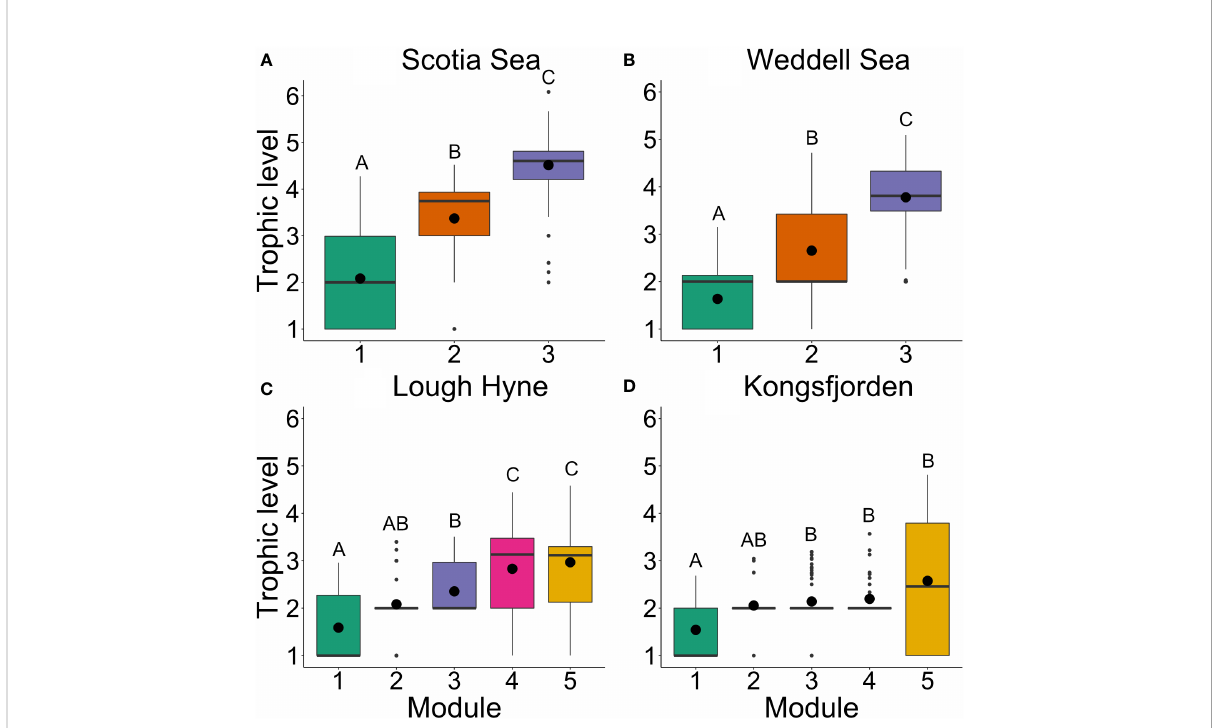
FIGURE 4 Boxplots of prey-averaged trophic level across modules within each network: (A) Scotia Sea; (B) Weddell Sea; (C) Lough Hyne; (D) Kongsfjorden. Large black points indicate the mean, thick horizontal lines represent the median, boxes indicate the interquartile range, whiskers are 1.5 × the interquartile range, and outliers beyond this range are indicated as small black points. Boxes not sharing a common letter are signi fi cantly different from one another using a Dunn ’ s test ( p < 0.05